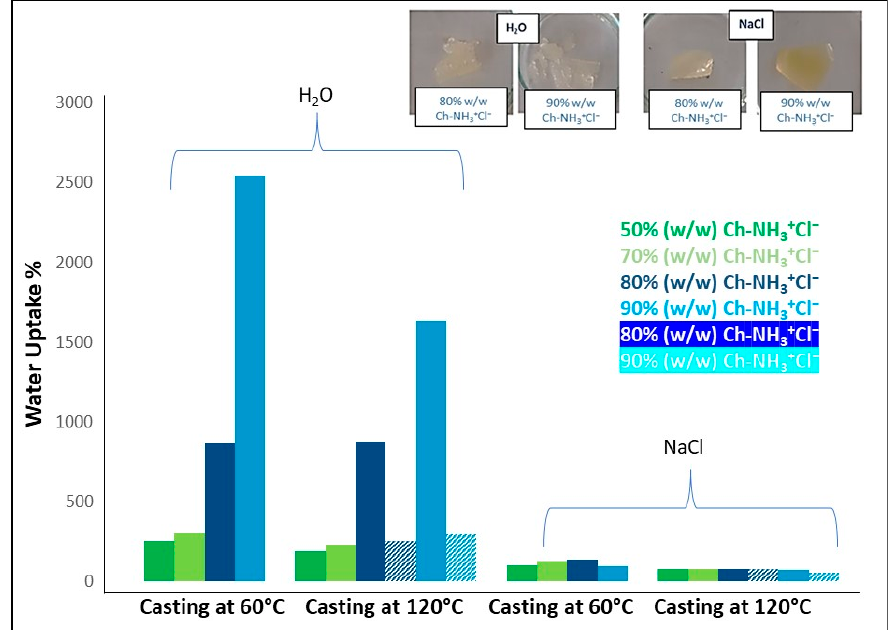
Figure 5. Water uptake of Ch-NH 3+ Cl − /P(DMAM-co-GMA) membranes with different molar ratio of Ch-NH 3+ Cl − , which were thermally treated at 60 ◦ C and 120 ◦ C. The appearance of the membranes with the highest Ch-NH 3+ Cl − content after immersion in the solvents is shown in the inset.